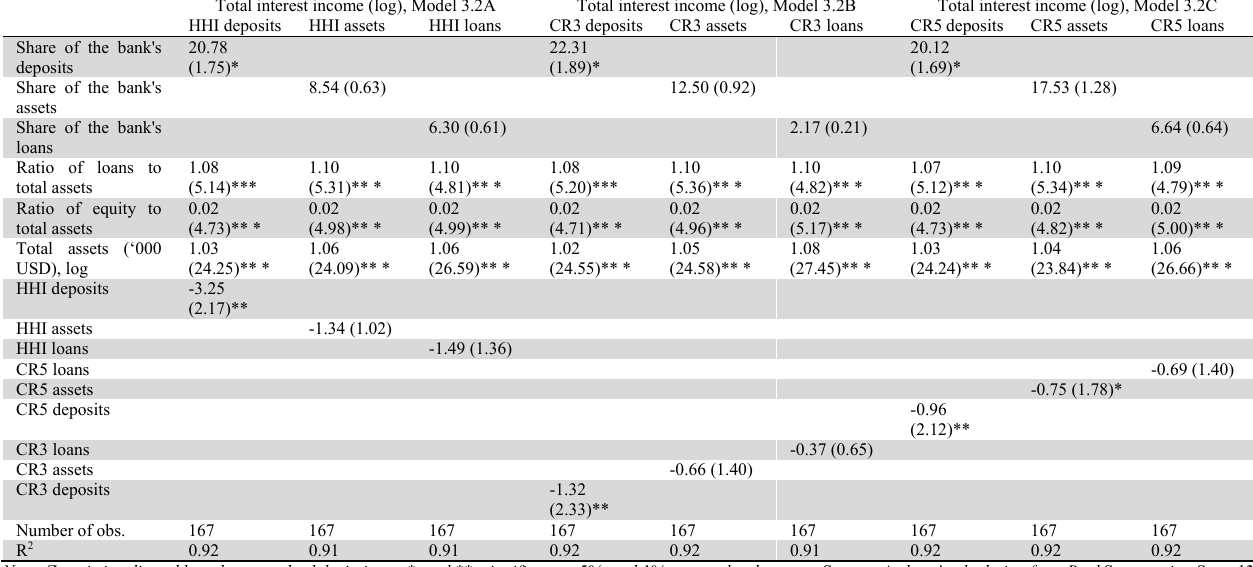
Effects of concentration on bank performance (Pooled OLS),